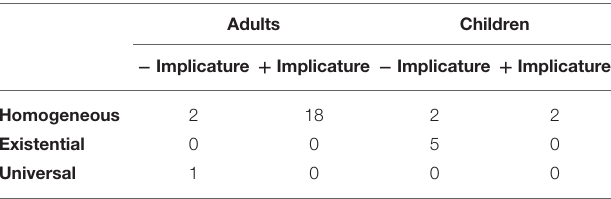
TABLE 7 | Distribution of participants across response types, after applying a TABLE 6 | Distribution of participants across response types, according to maximally stringent exclusion criterion that eliminated any participants who could performance on homogeneity and scalar implicature targets. potentially have had a bias for partial truth, against incomplete description, or Adults Children against scope